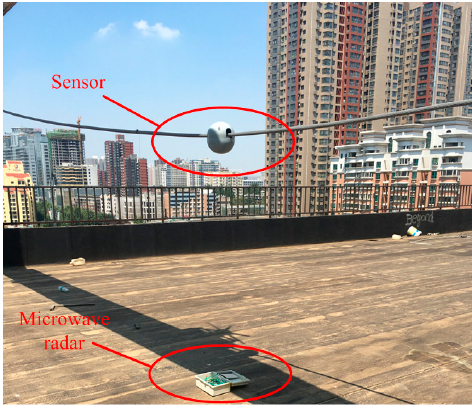
Figure 16. Experiment setup of a single sensor.